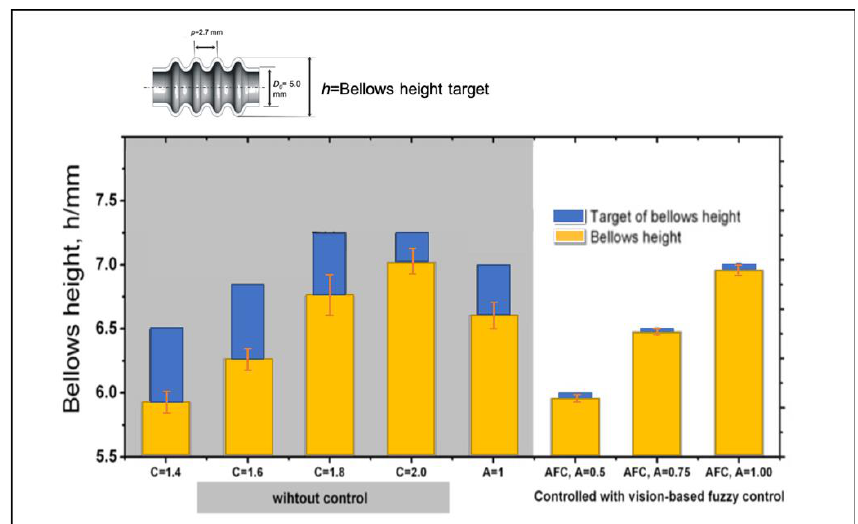
Figure 23. Evaluation of the bellows height under different bellows targets.